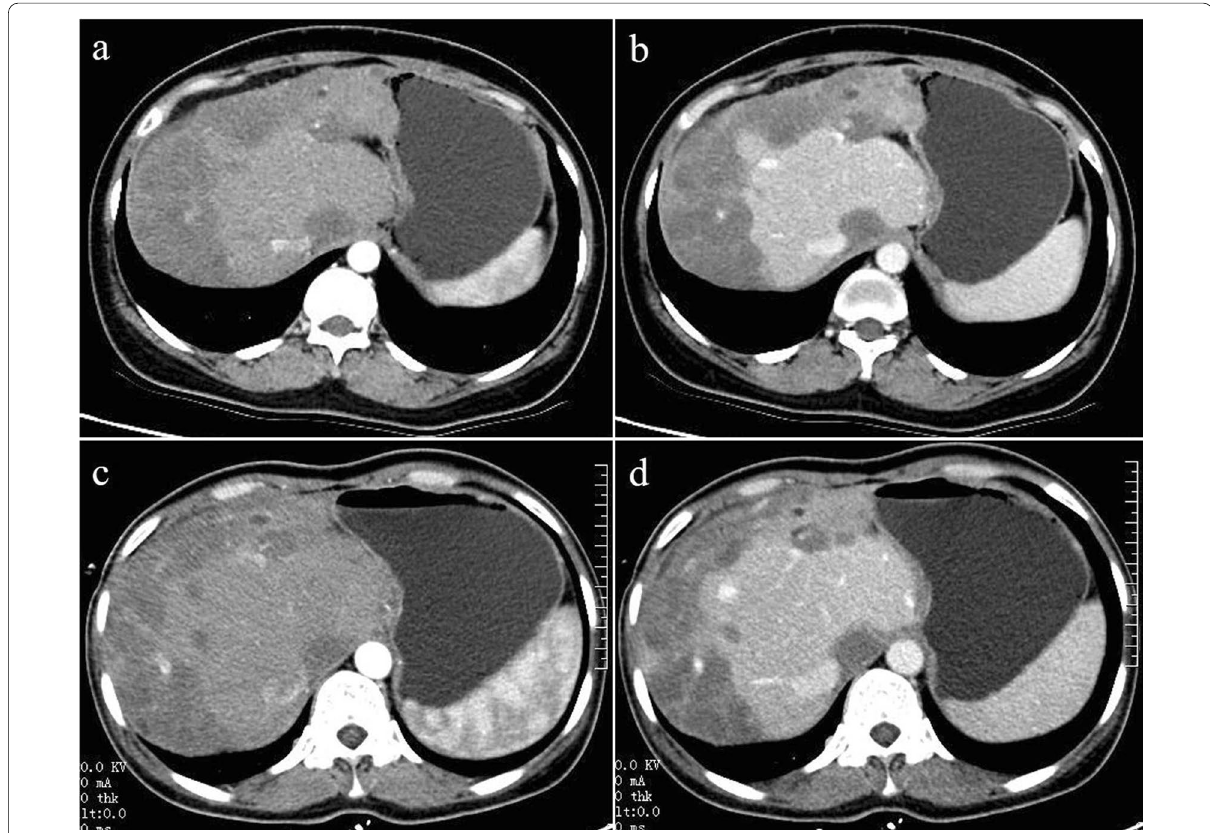
Fig. 4 A 40-year-old female with diffuse nodular type HEH. Axial arterial and portal phase CT images ( a , b ) show multiple, diffuse nodules that lack obvious enhancement and confluent masses with strip-like enhancement located at the subcapsular region of the liver, accompanied by liver morphological changes and proportion imbalance. On follow-up CT performed 18 months later without any treatment, axial arterial and portal phase images ( c , d ) show no obvious changes in the